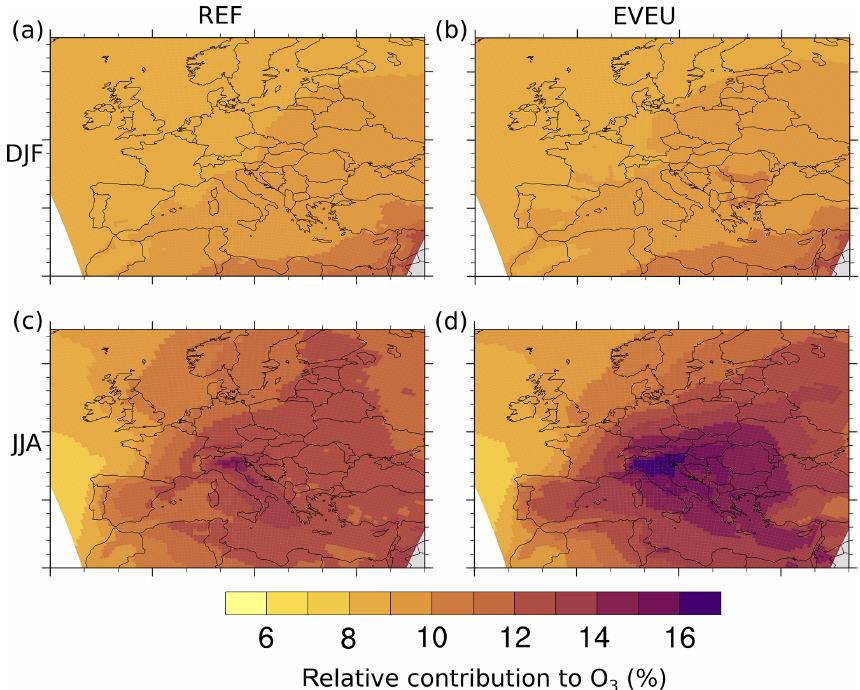
Figure 7. Relative contribution of land transport emissions to ground-level O 3 (in percent) as simulated by CM50. Panels (a) and (b) are contributions for the period DJF of the REF and EVEU simulations, respectively. Panels (c) and (d) are contributions for the period JJA of the REF and EVEU simulations,